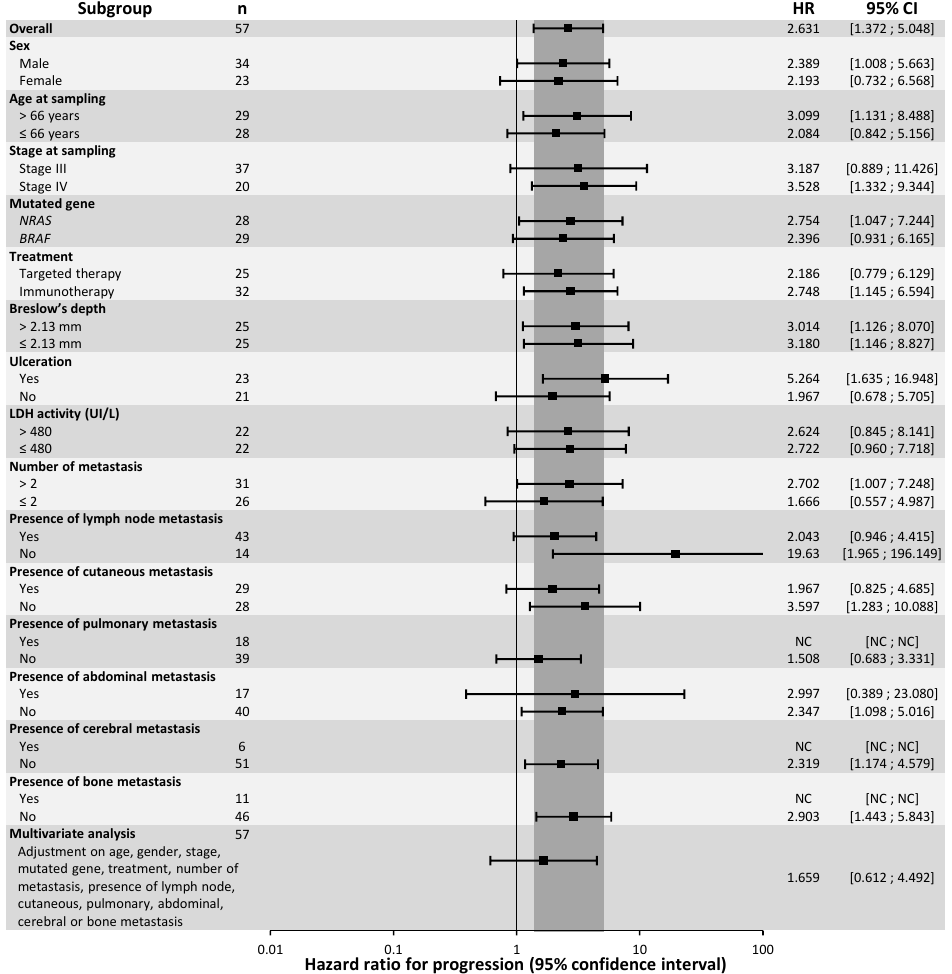
Figure 2. Subgroup and multivariate analysis of Progression-Free Survival, according to ctDNA detectability.